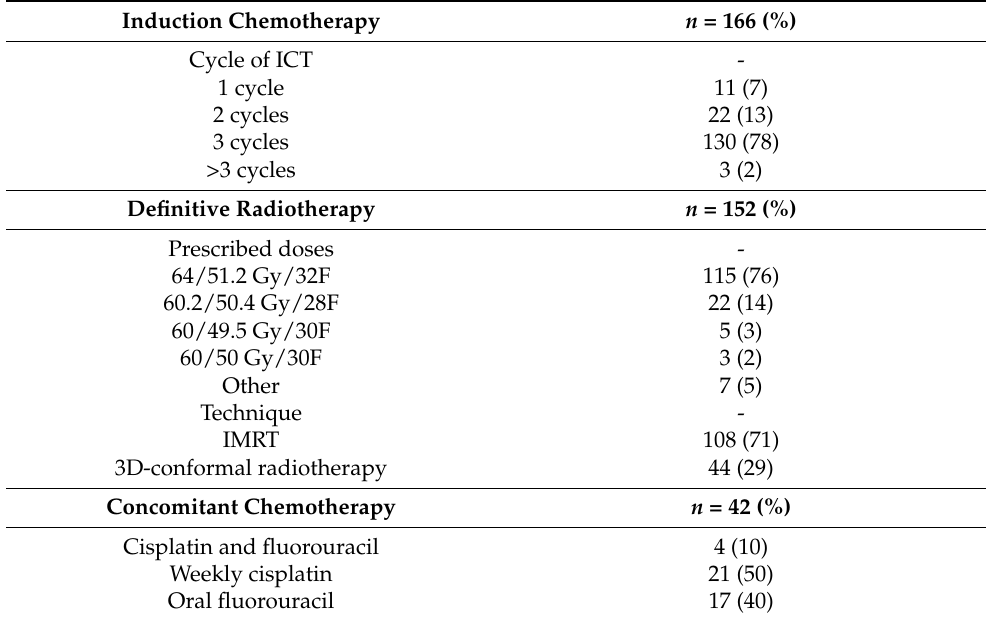
Table 2. Treatment characteristics.